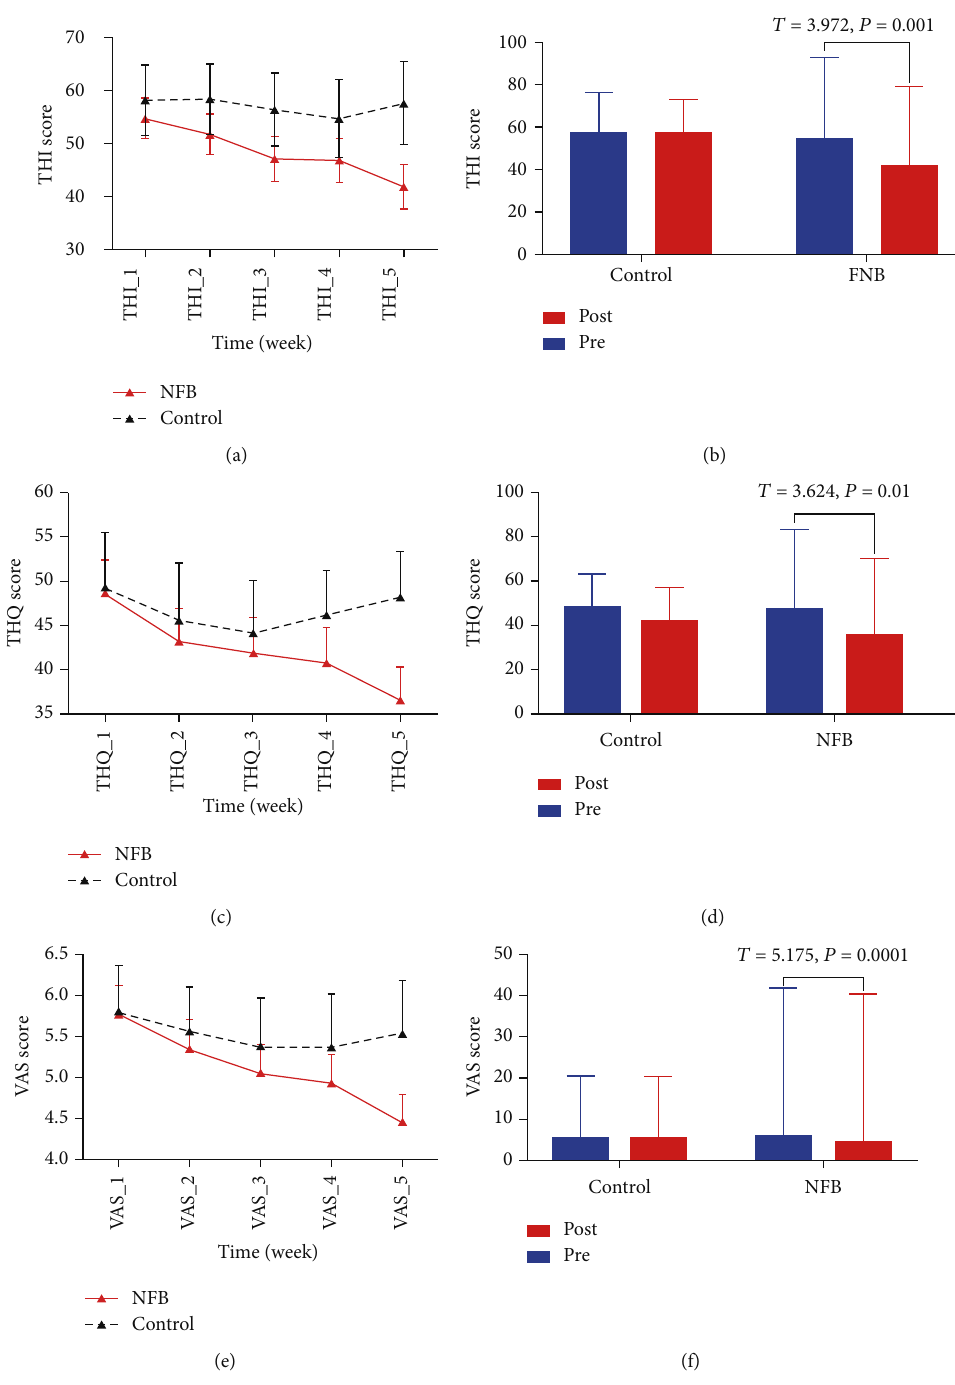
Figure 1: Self-reported tinnitus scores for the two groups over fi ve weeks. The data are showed as mean ± SD . THI score of two groups for fi ve weeks (a), comparison of pre- and posttreatment of total THI scores (b), THQ scores for the two groups over fi ve weeks (c), comparison of pre- and posttreatment of total THQ scores (d), VAS scores for the two groups over fi ve weeks (e), and comparison of pre- and posttreatment total VAS scores (f). NFB: neurofeedback group; control: control